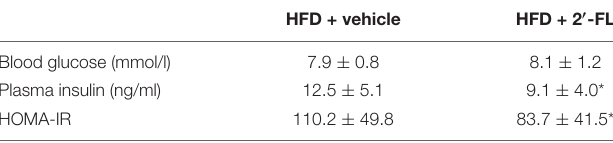
Asterisk indicates a significant difference relative to the HFD + vehicle control group (*p < 0.05). Data shown as mean ±